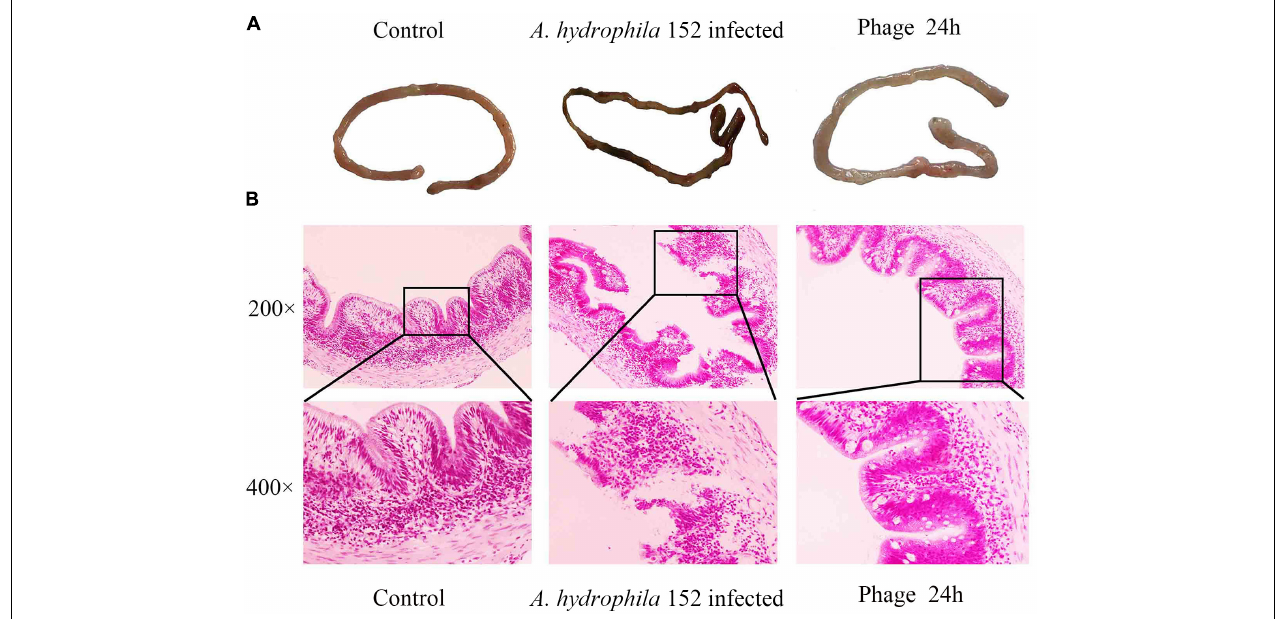
FIGURE 9 | Gross pathology and histopathology of the gut tissue. (A) At 1 h post infection, the gut was removed from the fish that were treated with 2 × 10 9 PZL-Ah152 or PBS. The gut of the healthy fish was used as controls. (B) The tissue samples were stained with haematoxylin and eosin.